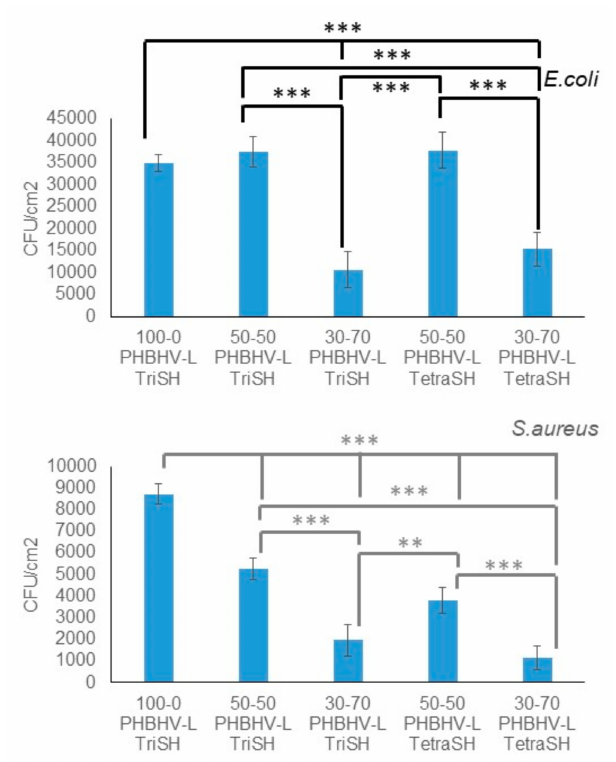
Figure 7. Antibacterial tests of PHBHV-L co-networks (** and *** are statistically di ff erent with p < 0.01 and 0.001,